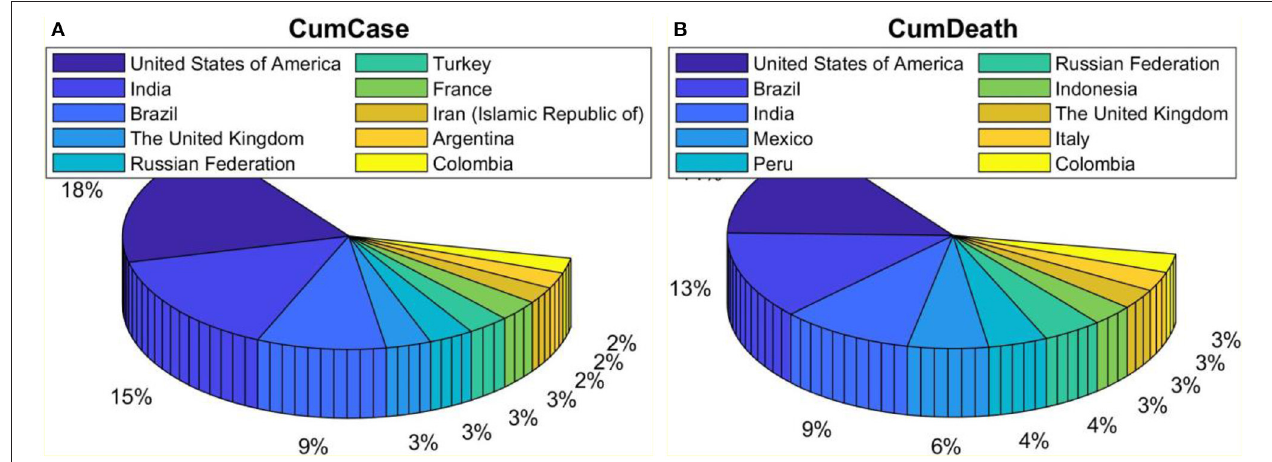
FIGURE 1 | Pie chart of COVID-19 related figures till 19/Sep/2021. (A) Cumulated positive cases. (B) Cumulated death tolls.